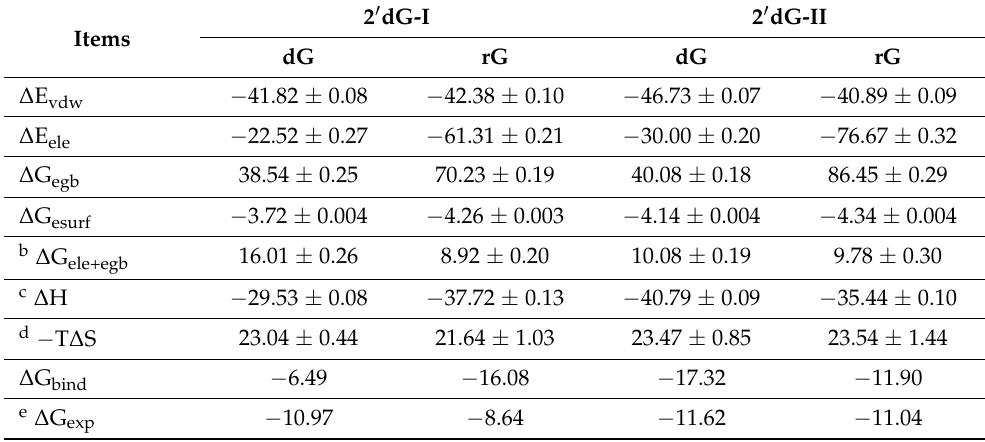
Table 2. Binding free energies for complexes of 2 (cid:48) -dG riboswitches calculated by MM/GBSA method a .